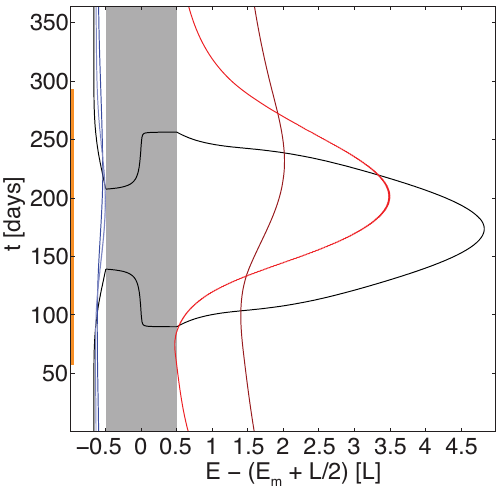
Fig. 5. Annual cycle of the instantaneous fixed points resulting from the surface energy budget (black curve) together with typi- cal system trajectories for 1b = 40Wm − 2 within the parameter regime of bistability (Fig. 4b): Trajectory of average cell energy (dark red) and surface cell energy (light red) for the equilibrated system starting from open water initial conditions; trajectory of av- erage cell energy (dark blue) and surface cell energy (light blue) for the equilibrated system for an initially frozen ice ocean layer. The vertical red line denotes the time of year when the system receives shortwave radiation (Arctic